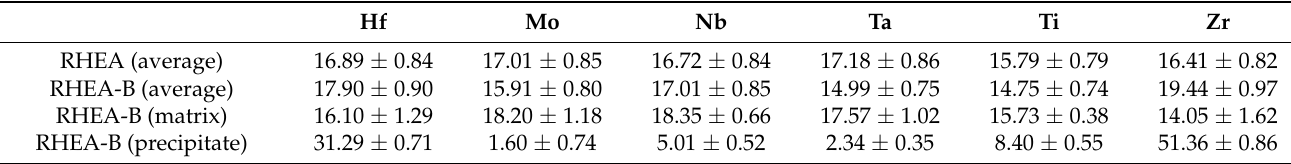
Table 3. Chemical Compositions of RHEA and RHEA-B Samples Measured by SEM EDS.